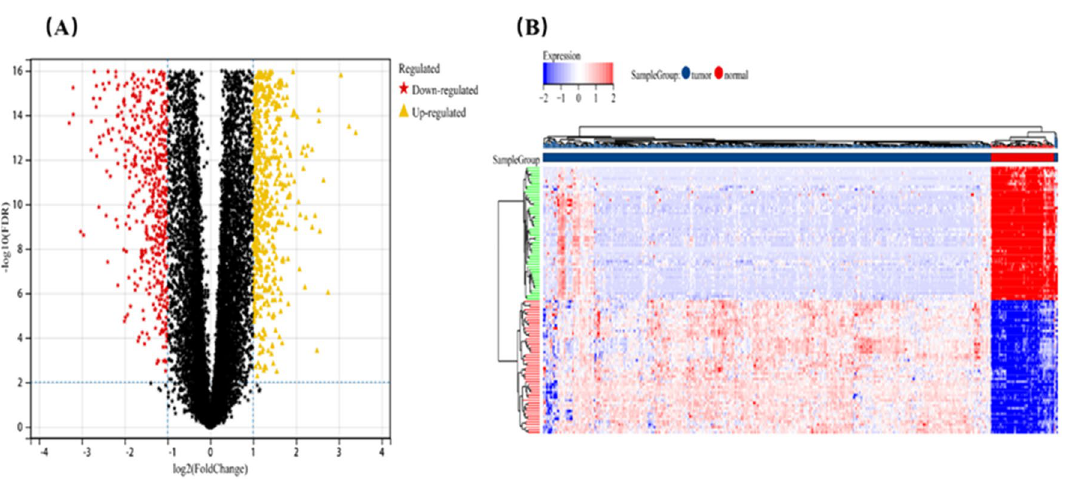
Figure 3. Identification of DEGs between 71 normal and 507 KIRC samples. ( A ) The volcano plot. Red dots represent down-regulated genes, black dots not-significant genes, and yellow dots up-regulated genes. ( B ) The heat map shows the expression difference of differentially expressed genes